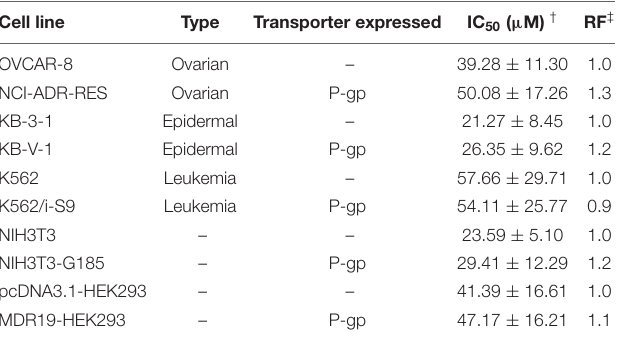
TABLE 3 | Cytotoxicity of branebrutinib in drug-sensitive and P-glycoprotein (P-gp)-overexpressing multidrug-resistant cell lines.